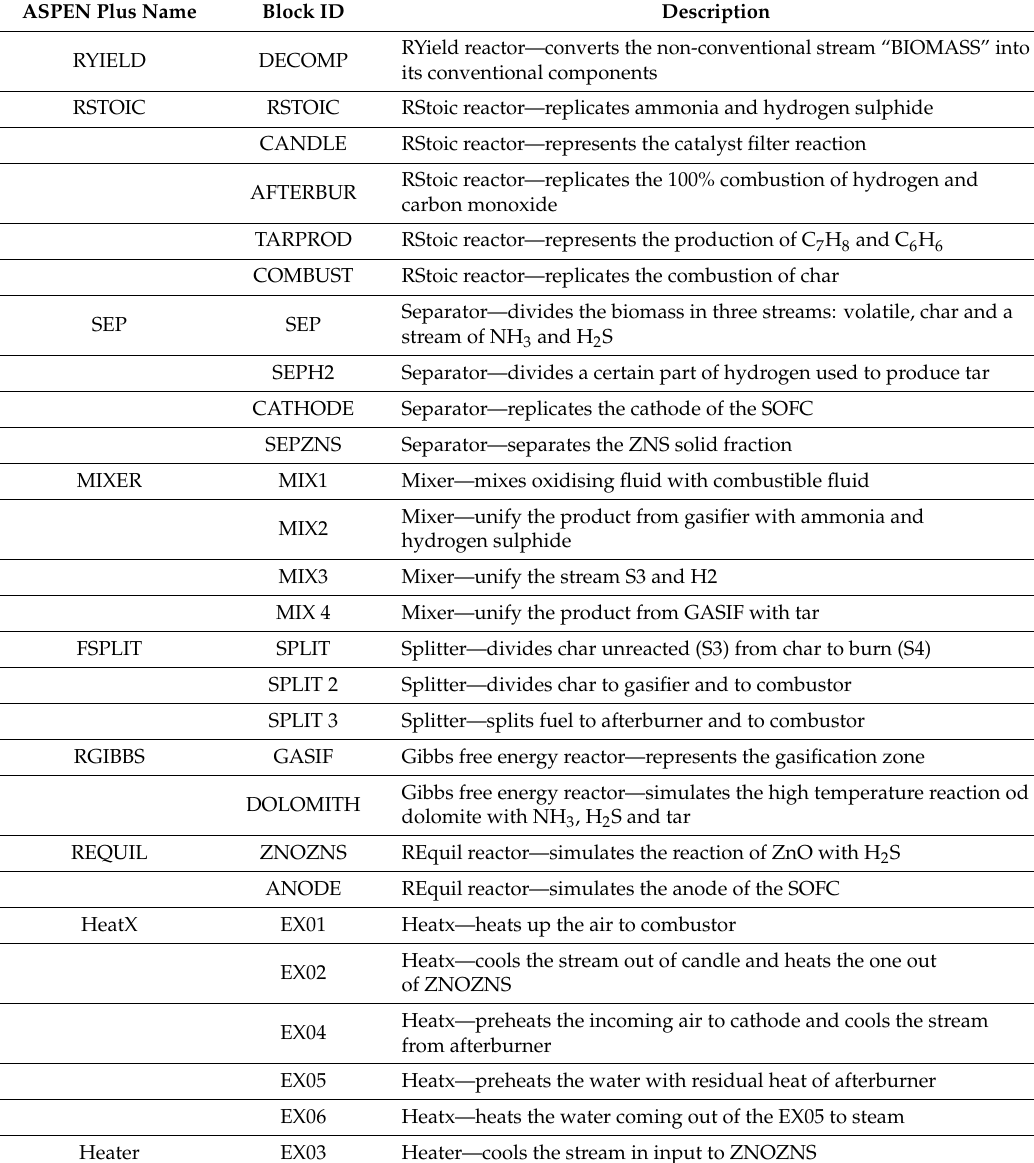
Table 1. Description of ASPEN Plus flowsheet unit operation presented in Figure